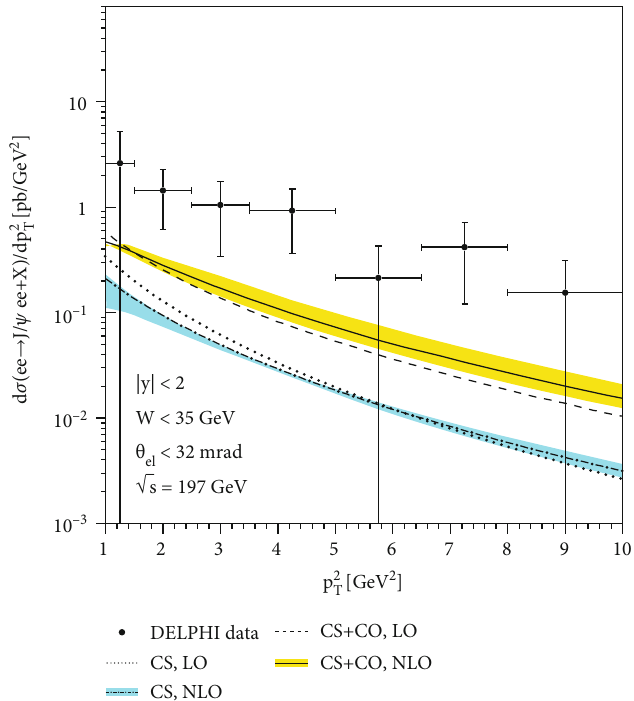
Figure 10: NLO NRQCD calculation compared to DELPHI data. Figure taken from Ref.